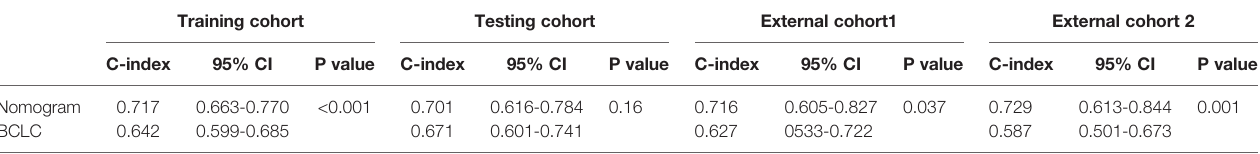
TABLE 5 | C-index of the nomogram and BCLC staging system for